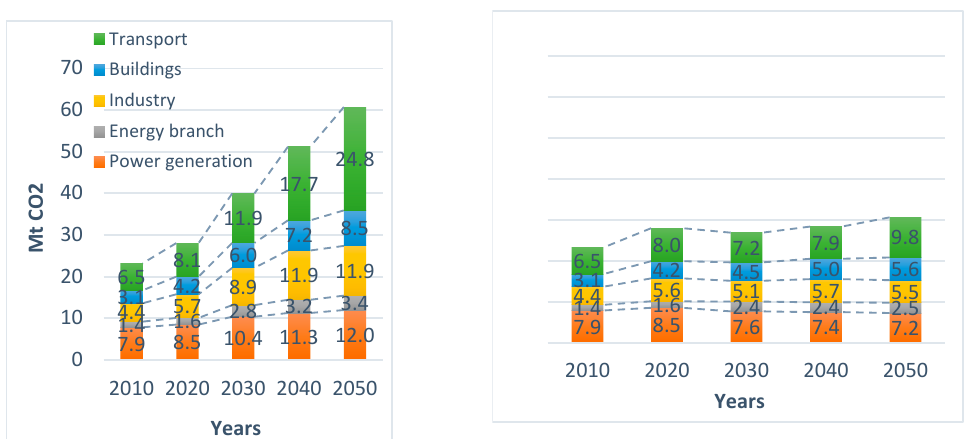
Figure 6. Tunisia’s CO 2 energy-related emissions by sector (Mt CO 2 ), over 2010–2050 ( Left : Unconditional scenario, Right : Conditional scenario), Source: MENA-EDS Model (Unconditional and Conditional NDC Scenarios).